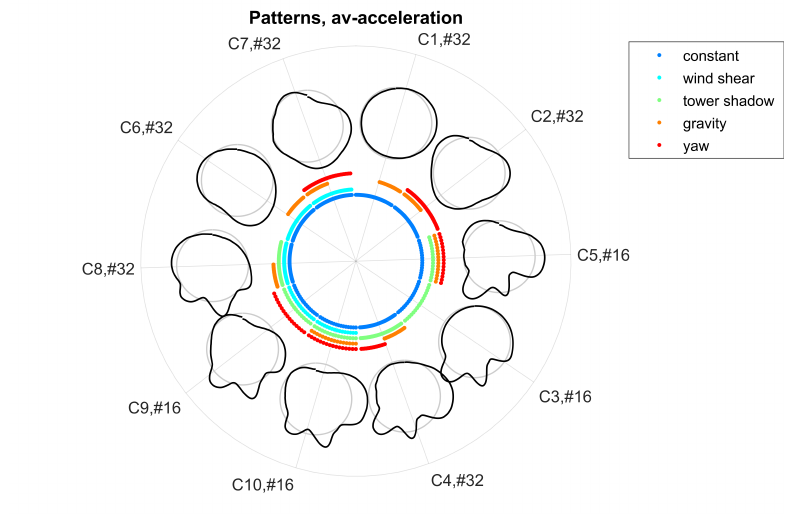
Figure 13. Resulting bending patterns for combined bending effects for a sensor mounting position of β = γ = 0° and R = 55m and a rotation frequency of f 0 = 0.2 Hz: bending effects are displayed along the coloured inner circle.